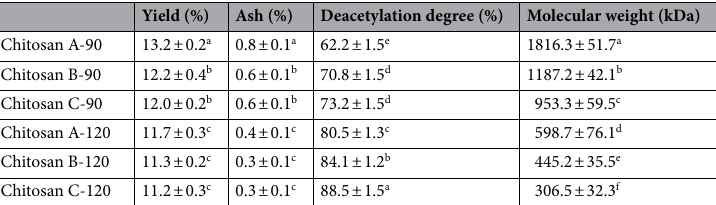
Table 1. Physiochemical parameters of chitosan extracted from swimming crab shells. Values with different letters in the same column are significantly different at p < 0.05. Data are expressed as mean ± standard deviation, n =